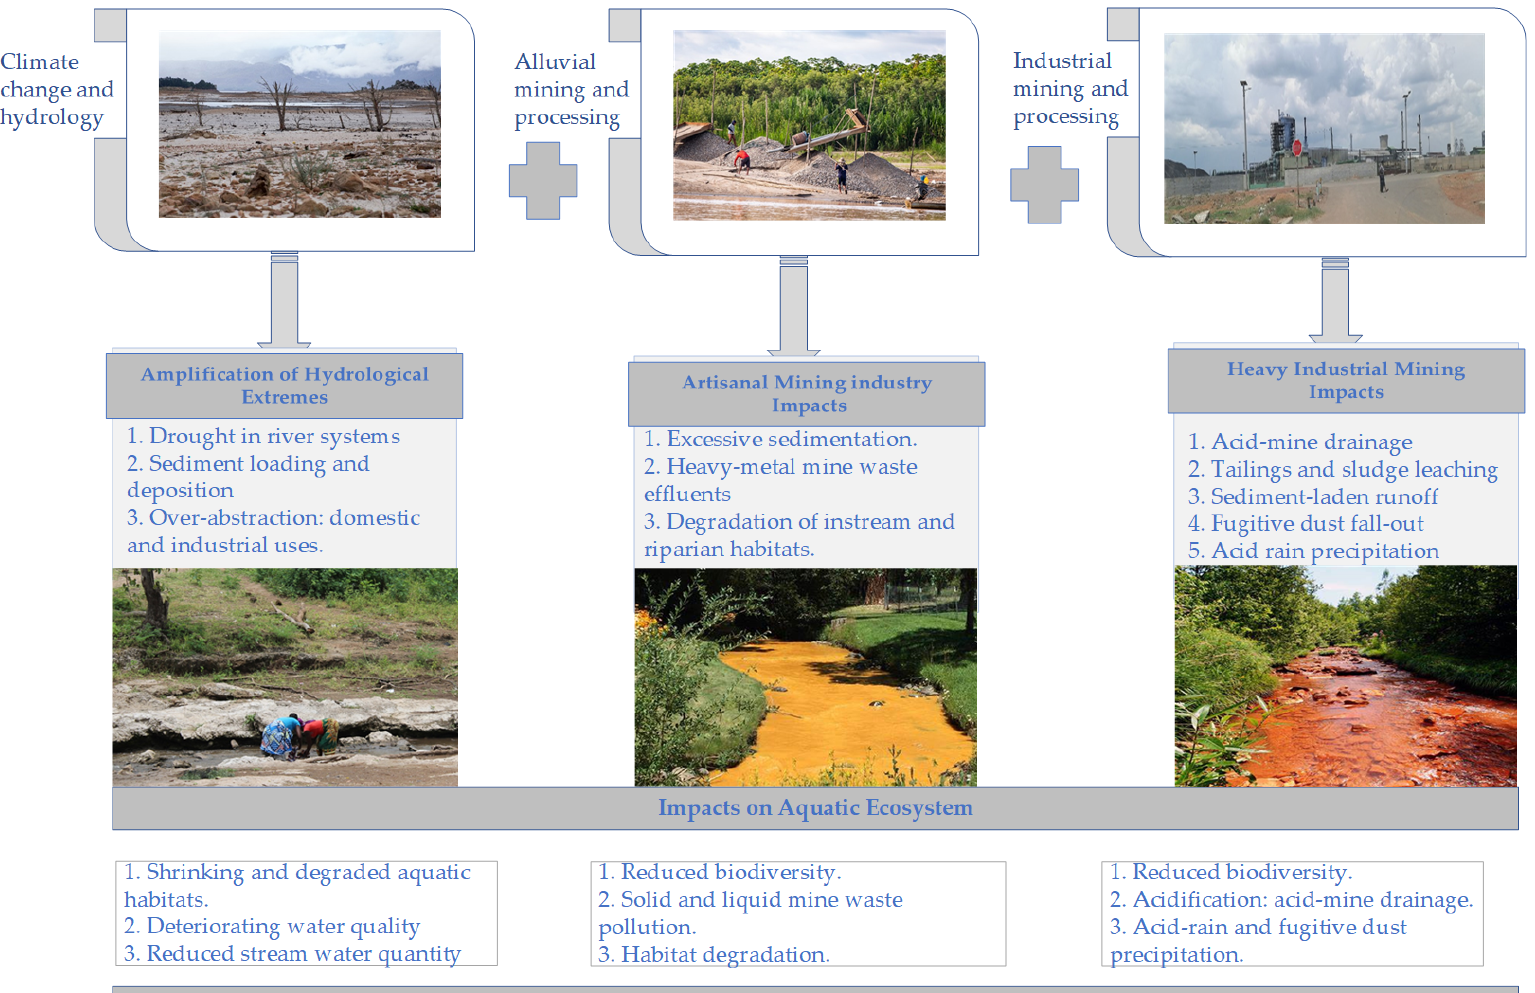
Figure 2. Threats to aquatic biodiversity and stream ecosystem functions from artisanal and industrial mining in river basins. The impacts of mining are further accentuated by the negative influences of climate change on stream hydroecology. Photo credits and copyrights: A. Hendricks; J. Houston; X. Rana; K. O. Ouma; L. Iaccino.